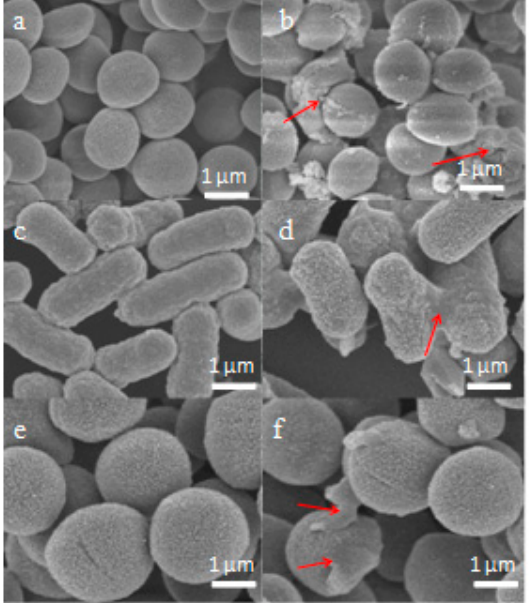
Figure 9. Scanning electron microscopy (SEM) micrographs of S. aureus , E. coli and C. albicans cells treated with peptides at their 1×MICs at 15 min. S. aureus : ( a ) control; ( b ) Der-PS4. E. coli : ( c ) control; ( d ) Der-PS4. C. albicans : ( e ) control; ( f ) Der-PS4. The control group did not contain peptides.